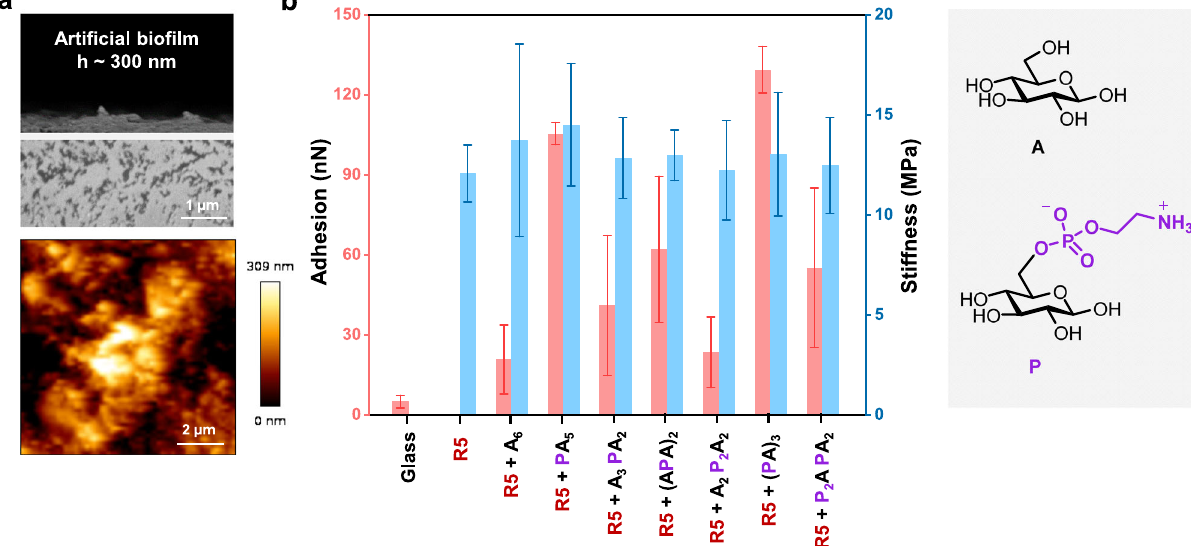
Fig. 4 Mechanical properties of arti fi cial matrices generated from the assembly of R5 in the presence of different hexasaccharides. a A cross-sectional SEM and AFM image of the fi lm of R5 with (PA) 3 . b Adhesions and stiffness resulting from AFM force-distance curves (see Supplementary Figs. 73, 74 and Table 17). Each data point corresponds to the mean of 50 – 100 force measurement and the error bars represent the standard deviation of the mean. Adhesion for R5 only could not be measured due to inhomogeneity of the fi